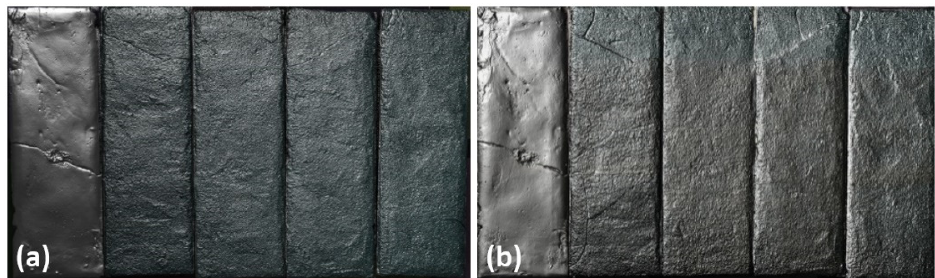
Figure 13. RTI documentation before ( a ) and after ( b ) cleaning